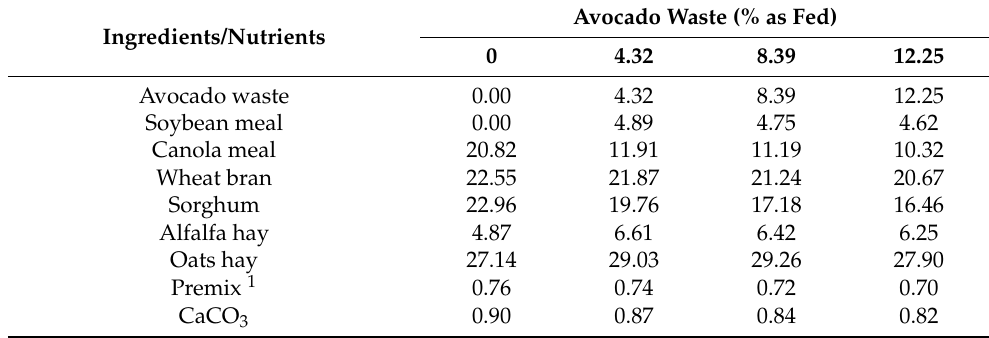
Table 1. Composition and chemical analysis of experimental diets.